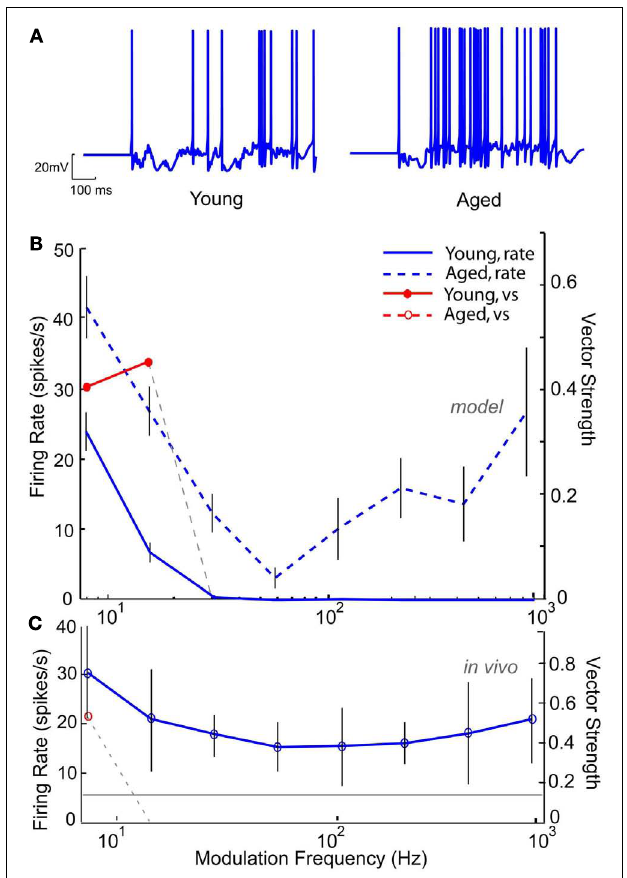
FIGURE 10 | Modeling age-related loss of synchrony through reduction in GABA A . IC Sustained model with two LSO inputs and three DNLL all-pass and the membrane potential at − 60mV. (A) Example voltage traces from individual trials at 16Hz modulation frequency for a young (left) and aged (right) model neuron. (B) Changes in mean firing rate shown for a young model neuron (blue solid line) and an aged model neuron with 50% reduction in GABA A (blue dashed lines). Significant vector strengths shown for a young model neuron ( filled red circles ) and an aged model neuron ( red open circles , not present in the model). Firing rate, in spikes/s, and vector strength are marked along opposing Y -axes and modulation frequency in Hz is marked along the X -axis. Error bars indicate one standard deviation from the mean of 10 trials. (C) Representative neuron A15 from an aged animal showing a weak low-pass rMTF ( blue solid lines ) and reduced synchrony ( red open circle ) to sAM stimuli presented at 75dB SPL and centered at 16 KHz. Gray line indicates mean spontaneous firing rate. Axes same as (A) .